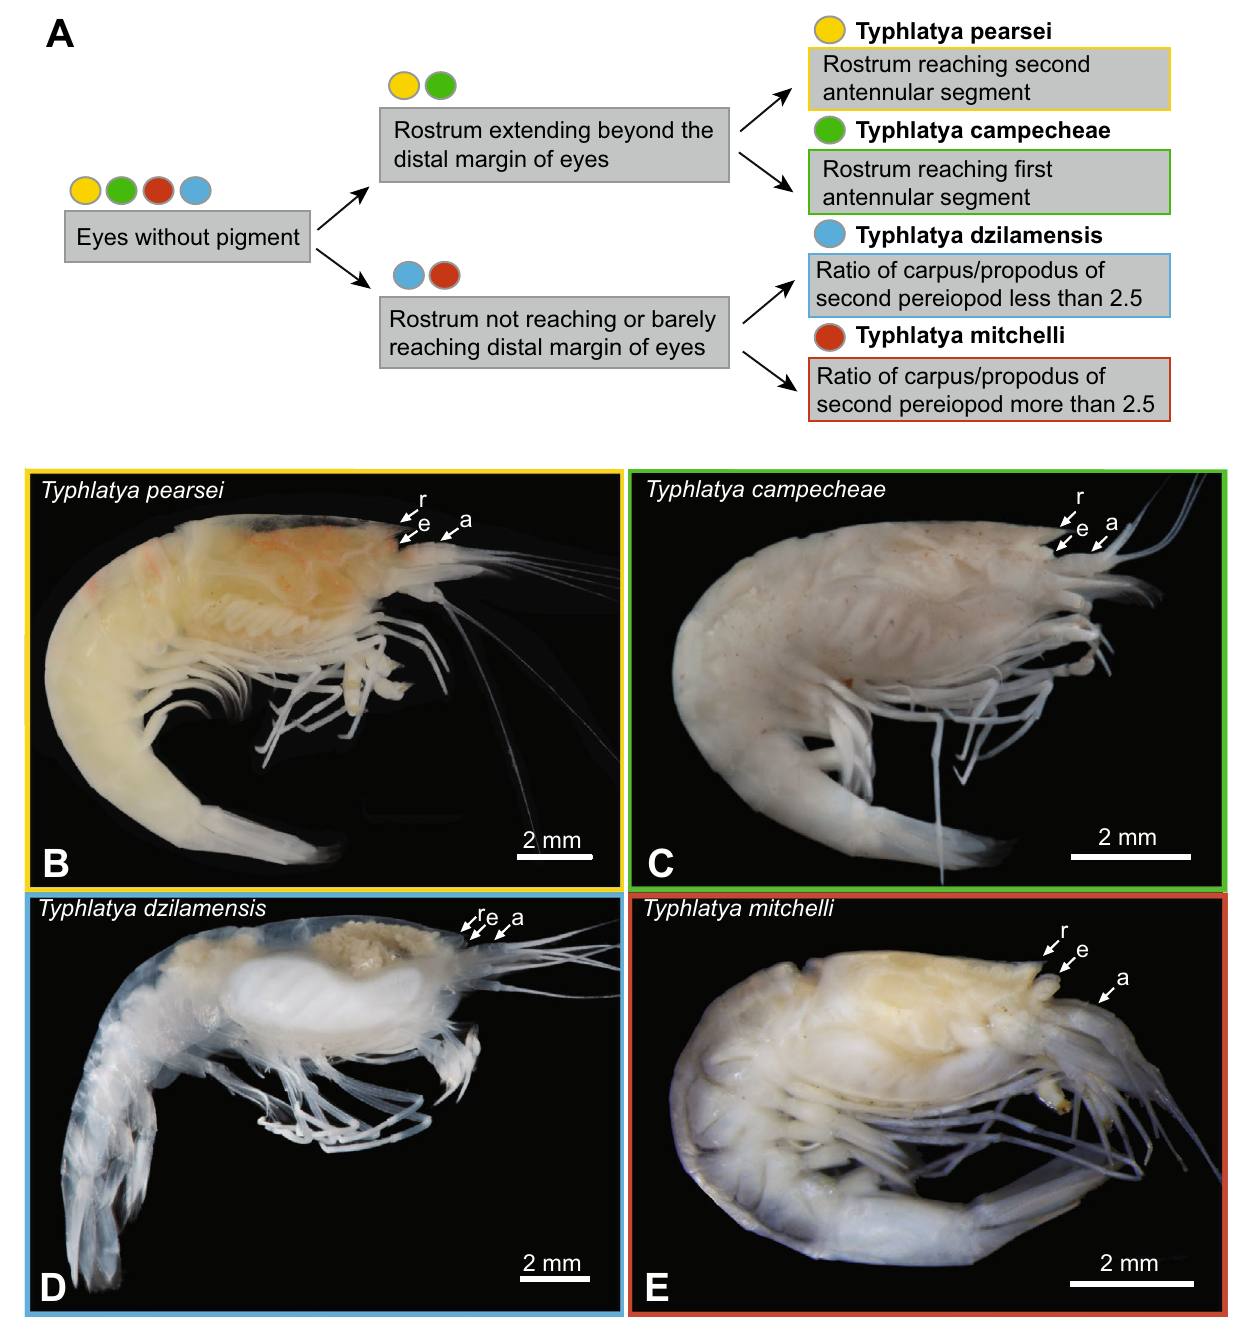
Figure 3. ( A ) Graphical morphological key of Typhlatya spp. of the Yucatán Peninsula adapted from Alvarez et al. 25 ; ( B–E ) Species of the Yucatán Peninsula. ( B ) Typhlatya pearsei (‘Ultimo Suspiro’, near Dzilam de Bravo); ( C ) Typhlatya campecheae (Grutas de Xtacumbilxunam; ID = C2*); ( D ) Typhlatya dzilamensis (Cenote Crustacea); ( E ) Typhlatya mitchelli (Sistema Paamul; ID = TI008D*). a , Antennular peduncle; e eyes, r rostrum. Images taken by ECS, AL, SR, and AS. *Genetically identified in this study, Fig.